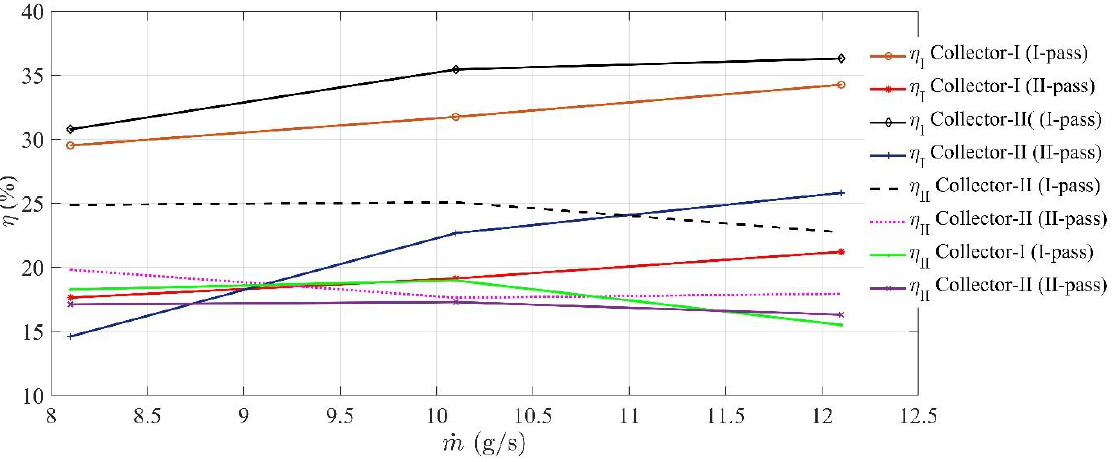
Figure 9. The variation in η I and η II with the air flow rate when flowing across the two parallel